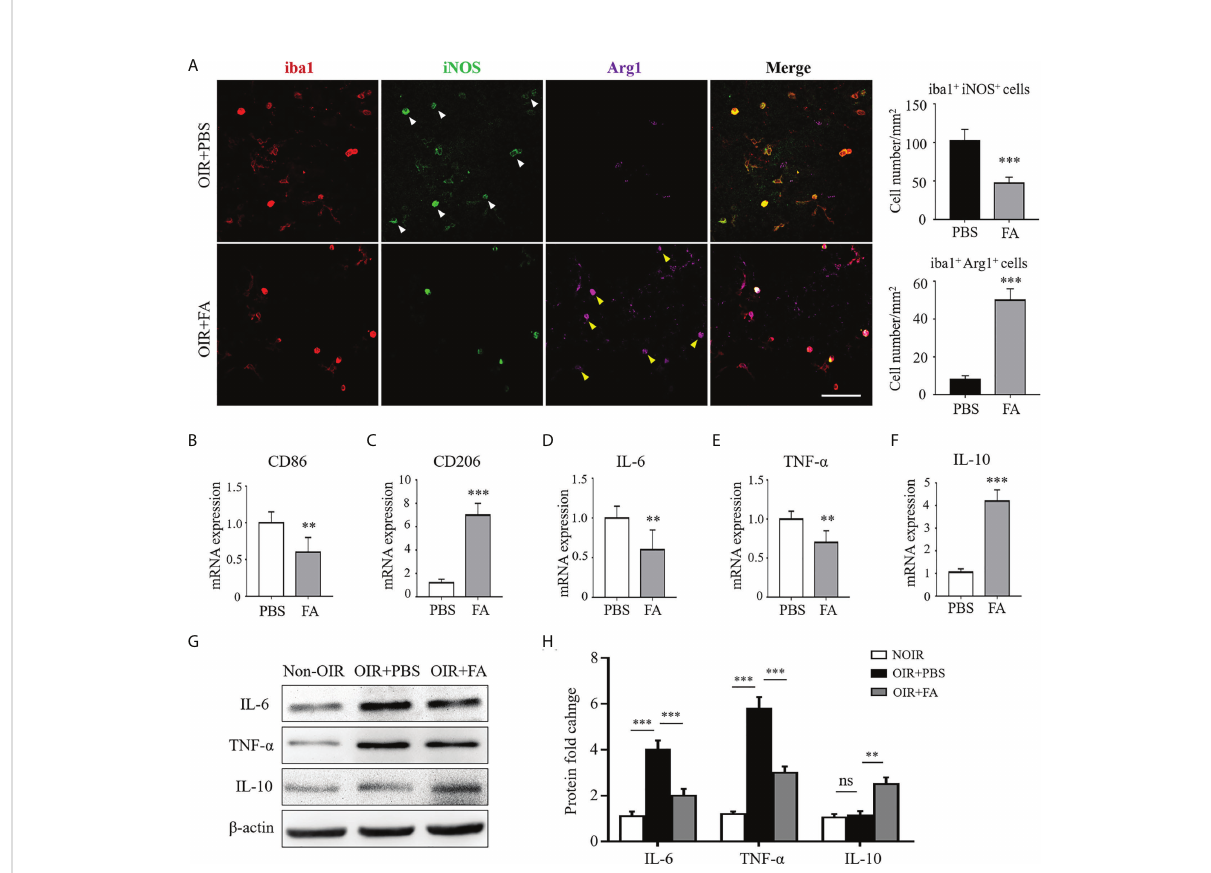
FIGURE 3 FA switched microglia/macrophage phenotypes from a pro-in fl ammatory “ M1 ” to an anti-in fl ammatory “ M2 ” . (A) Immunostaining on retinal whole-mounts showed that iba1 + microglia/macrophages expressed higher levels of iNOS (white arrowheads) rather than Arg1 in the OIR retina. Note that FA treatment led to an increased number of Arg1 + iba1 + cells (yellow arrowheads) but decreased number of iNOS + iba1 + cells. Scale bar, 100 m m. N = 6 mice. (B, C) Real-time PCR showed that FA supplement down-regulated CD86 expression (B) while increased CD206 mRNA levels (C) . (D – F) Pro-in fl ammatory IL-6 (D) and TNF- a (E) were decreased while anti-in fl ammatory IL-10 (F) was signi fi cantly up-regulated after FA treatment. n = 6 mice. (G, H) Western blot assay showed that FA treatment decreased levels of IL-6 and TNF- a , whereas increased